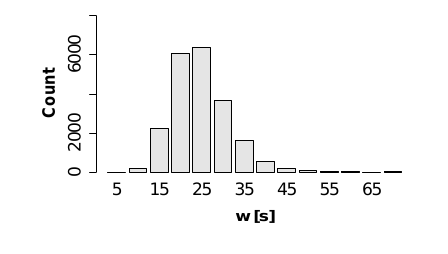
Fig. 12. Relationship of 50-Hz current densities’ peaks, (cid:12) (cid:12) (cid:12) j 50Hz , peak (cid:12) , and solar zenith angle χ . The format is the same as in Fig. 9.